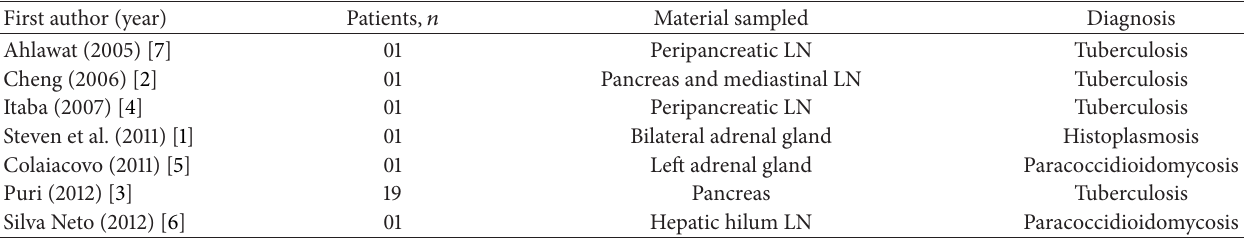
Table 1: Characteristics of other cases or series published in the literature on the diagnosis of infectious diseases by endoscopy or bronchoscopy ultrasound-guided fine needle